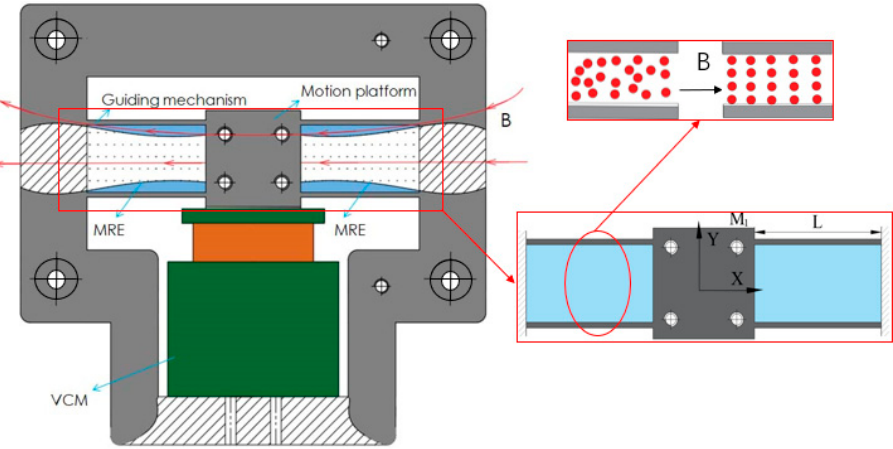
Figure 1. Schematic diagram of the proposed nanopositioner configuration.